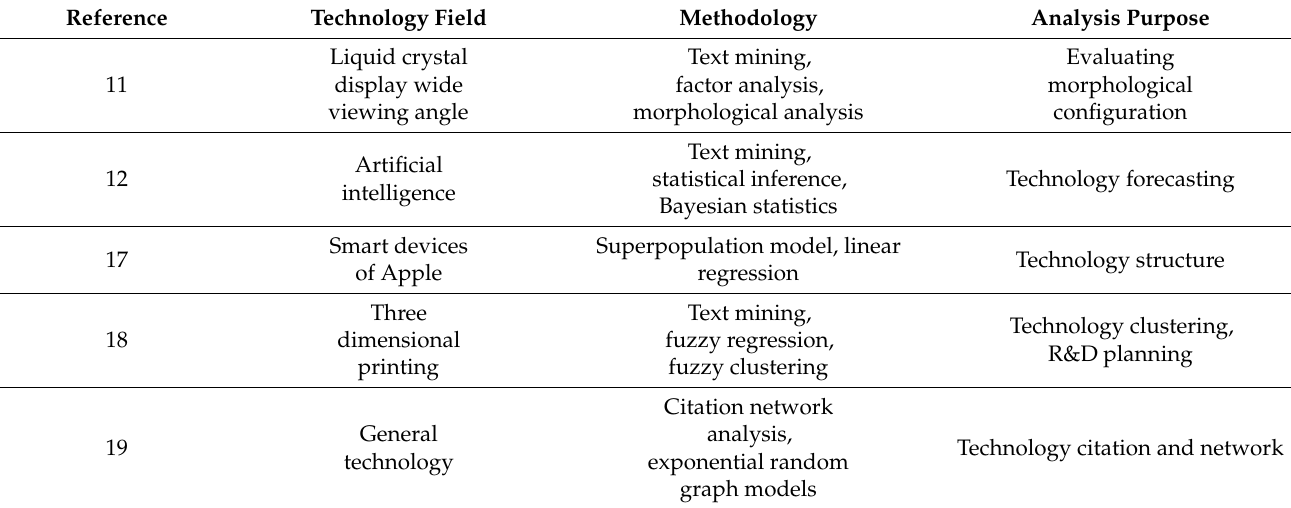
Table 1. Comparison of patent data analysis.